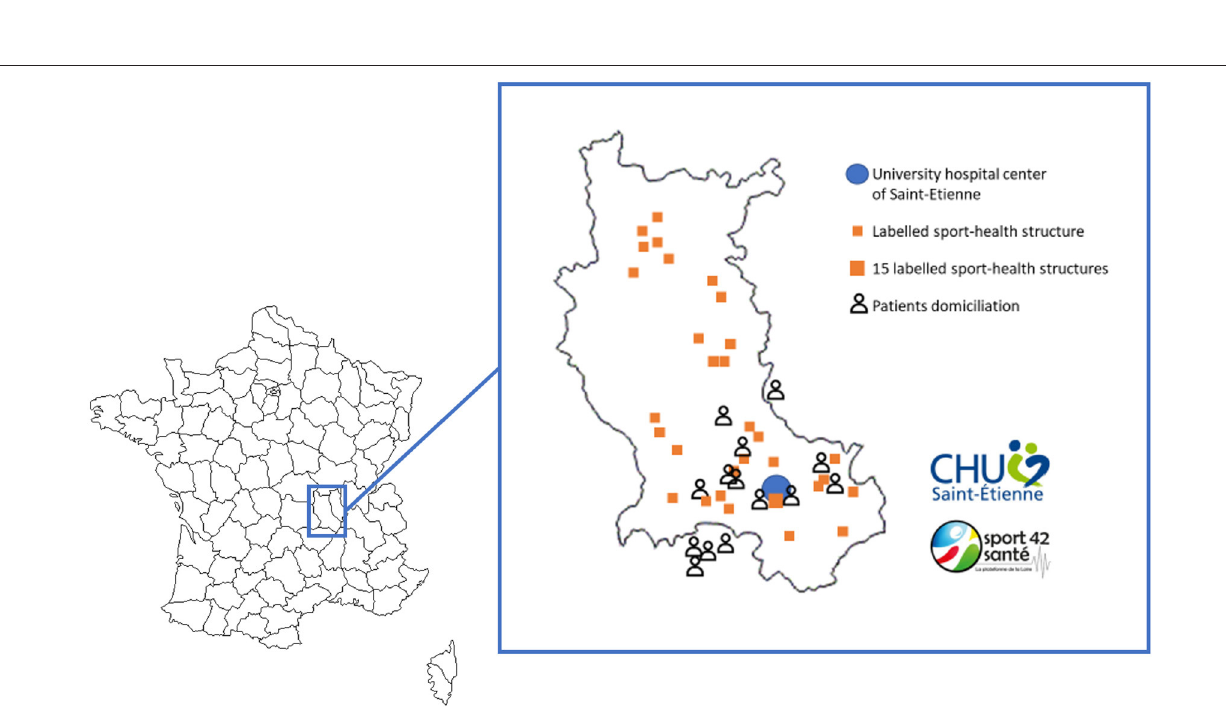
three physiotherapy sessions per week for 4 weeks.